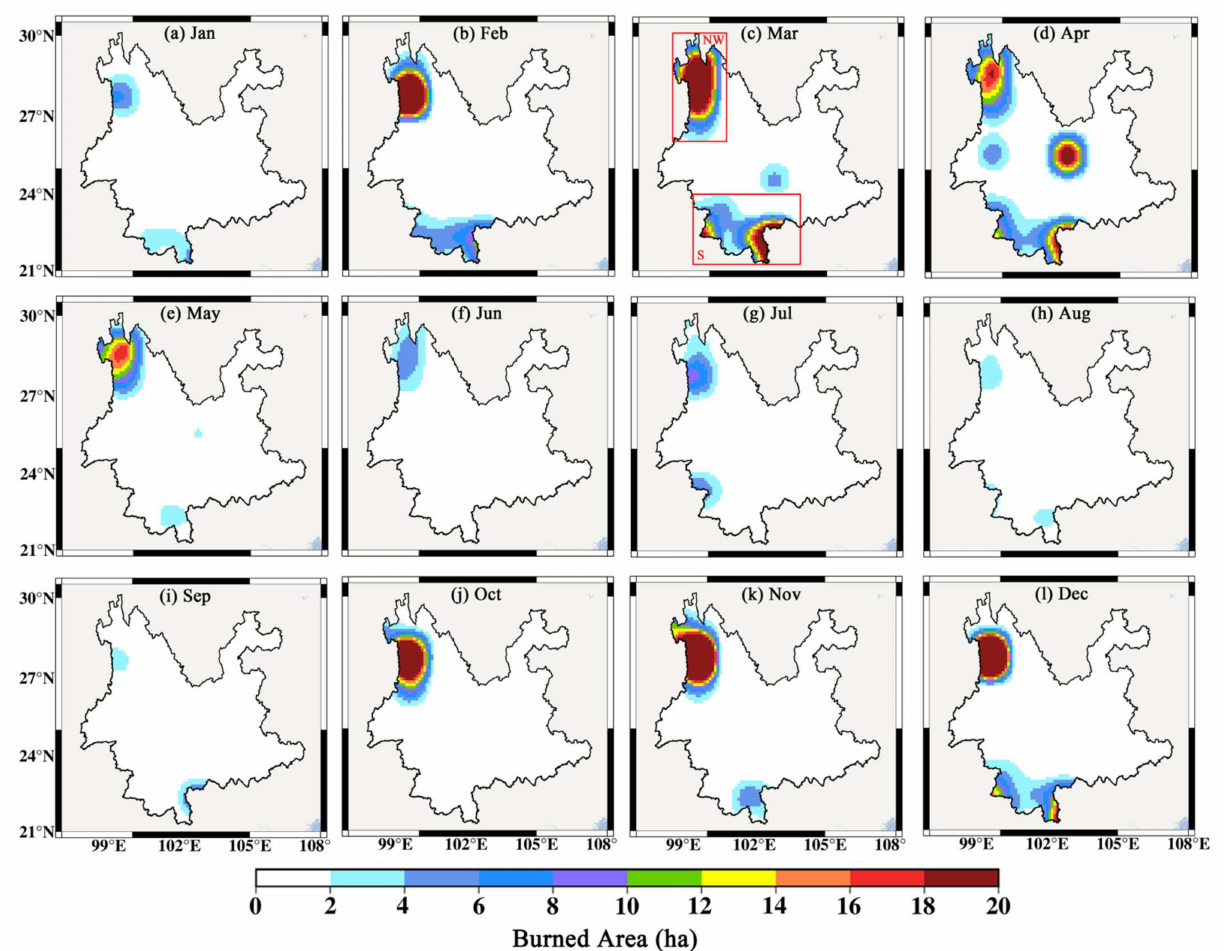
Figure 5. The spatial distribution of the monthly burned area averaged from 2003–2016 across Yunnan. ( a–l ) represent the results from January to December, respectively. (NW: Northwestern; S: Southern).